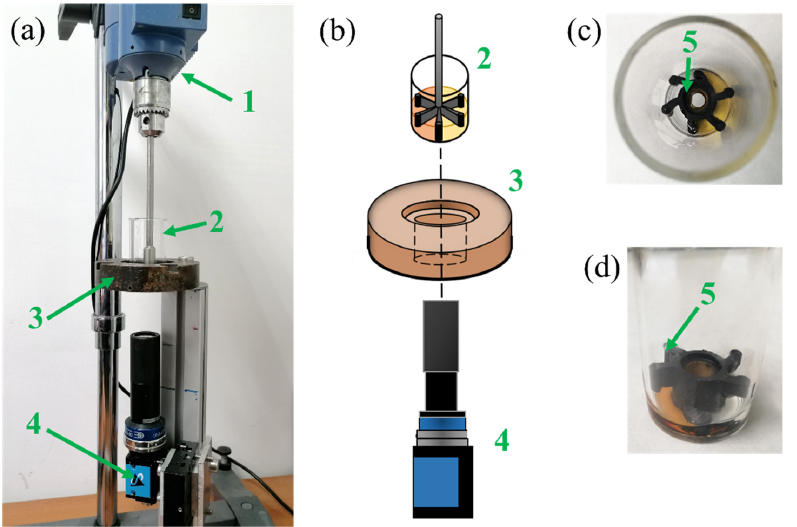
Figure 1. ( a ) Optical setup composed of (1) the mixing head, (2) the sample holder, (3) the copper plate used to keep the sample holder and (4) the high-speed camera. ( b ) Scheme of the optical setup. ( c ) Sample holder with (5) the rubbery impeller keeping the two reactants separate before the mixing stage and ( d ) its top view.